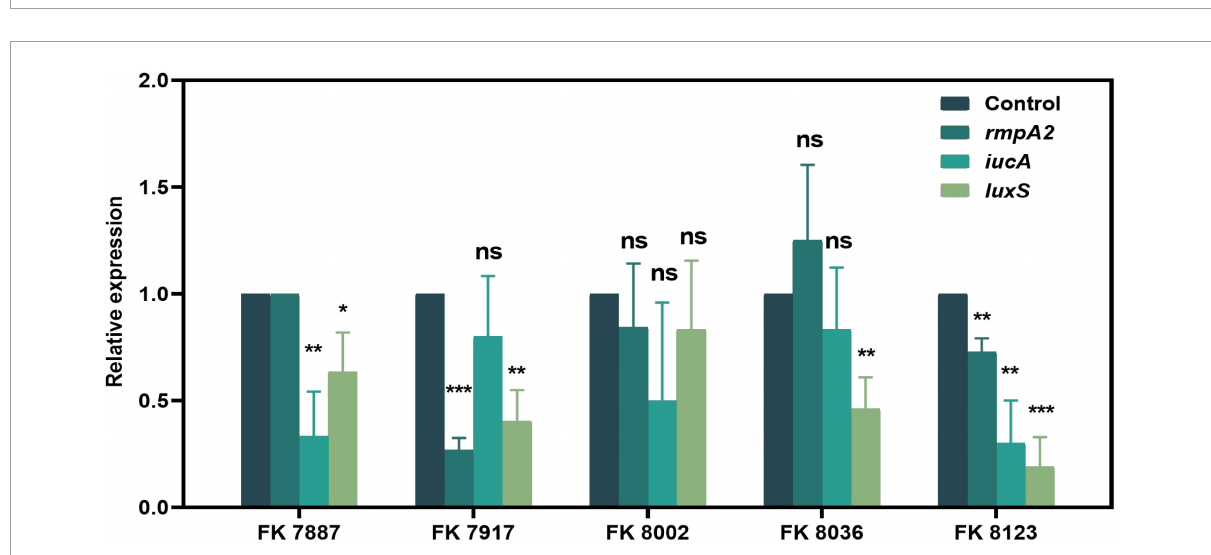
FIGURE10 The expression of quorum sensing (QS)-related genes of five carbapenem-resistant Klebsiella pneumoniae (CRKP) strains in different treatment groups. The strain FK 7887 did not carry the rmpA2 gene, hence this result will not be discussed. “*” Means P < 0.05, “**” means P < 0.01, “***” means P < 0.001, and “ns” means P >